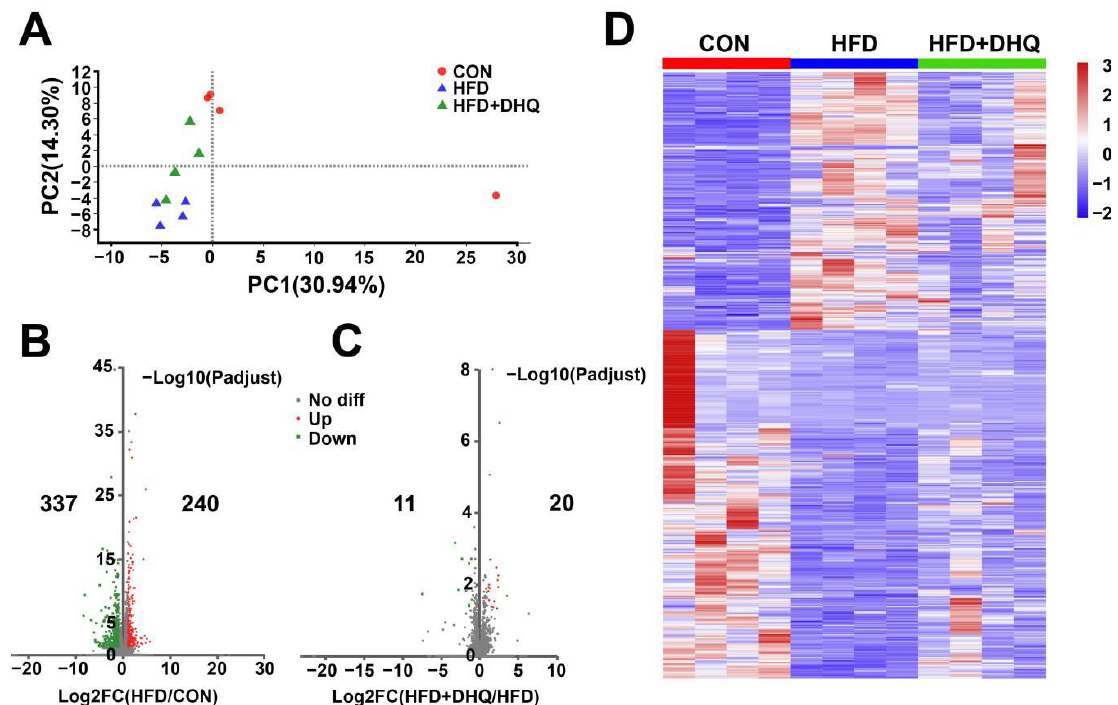
Figure 4. Effects of DHQ on hepatic genes expression in mice. ( A ) PCA score plots; ( B ) volcano plots of DEGs in CON vs. HFD; ( C ) volcano plots of DEGs in HFD vs. HFD+DHQ groups. Each dot represents a particular gene, and its corresponding horizontal and vertical values are gene expressive changes in the CON and HFD groups or HFD and HFD+DHQ groups, respectively. The red dots mean up-regulated genes expressed significantly, the green dots mean down-regulated genes expressed significantly, and the gray dots mean the genes expressed not significantly; and ( D ) heatmap of all DEGs altered by HFD and DHQ treatment. Nutrients 2022 , 14 , x FOR PEER REVIEW